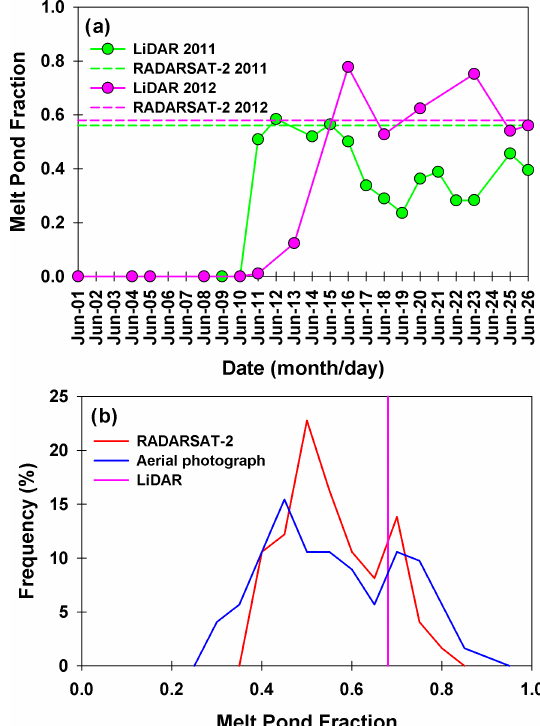
Figure 7. (a) Temporal evolution of observed melt pond frac- tion ( f p ) and RADARSAT-2 peak melt pond fraction ( f pk ) at in situ observation sites for 2011 (74.7229 ◦ N, 95.1763 ◦ W) and 2012 (74.7264 ◦ N, 95.5772 ◦ W). (b) Frequency distribution of RADARSAT-2 f pk and aerial photograph f p observations in Reso- lute Passage on 22 June 2012; the pink vertical link represents the mean lidar f p on 22 June